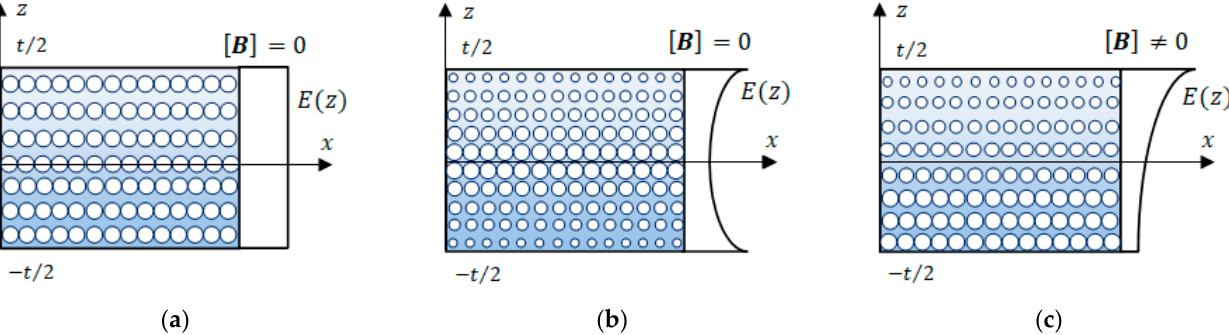
Figure 2. Plate wall construction for the uniform thickness t(x,y,z) = t: ( a ) uniform distribution of pores, ( b ) symmetric distribution, and ( c ) unsymmetric distributions.